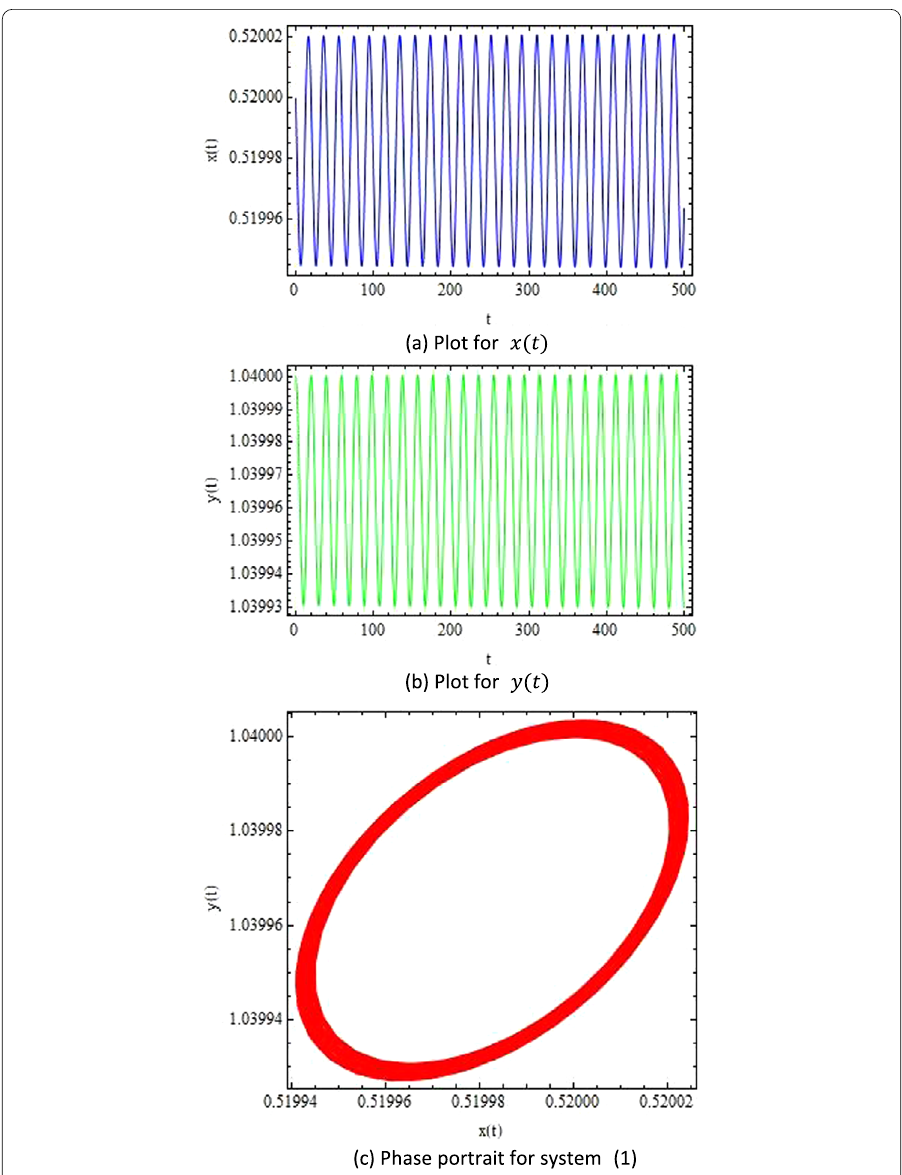
Figure 2 Plots for system (1) with r = 1.2, k = 1.5, α = 0.45, β = 0.2, h = 0.5, s = 0.1659505778939415 and ( x 0 , y 0 ) =